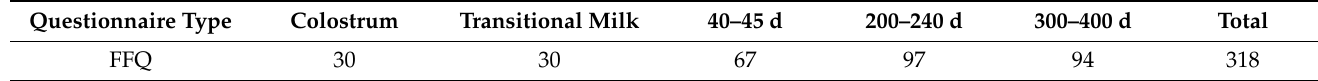
Table 6. The recovery of valid questionnaires in Guangzhou (unit: